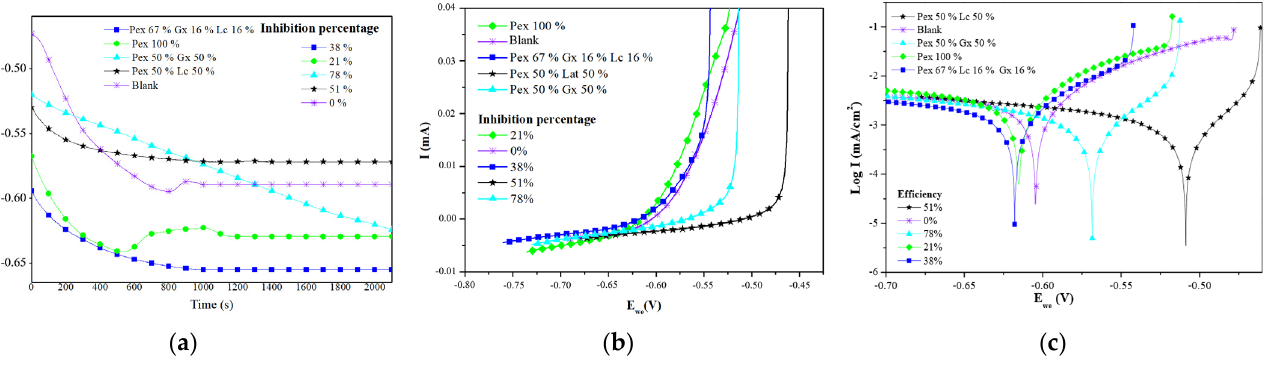
Figure 5. Curves from the linear polarization test of the formulations with the most prominent effect: ( a ) open circuit potential curves; ( b ) linear polarization curves; ( c ) Tafel curves.